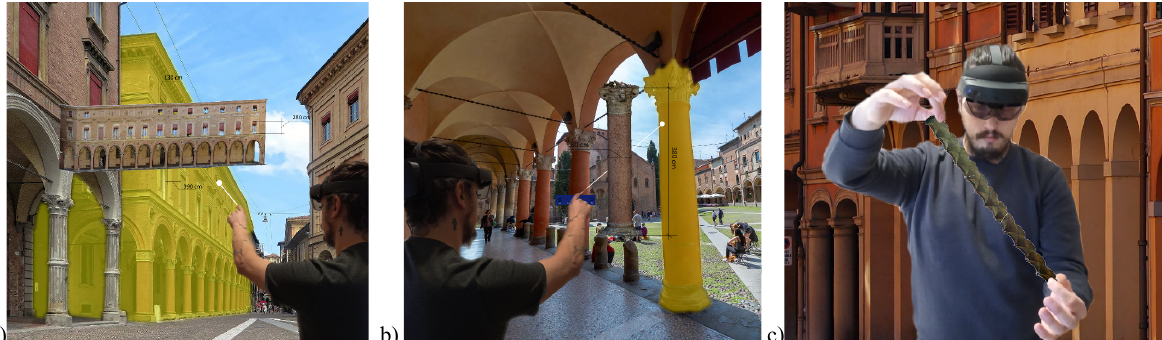
Table 3. Porticoes in Bologna: classification levels, metrics and point cloud resolutions at each level.